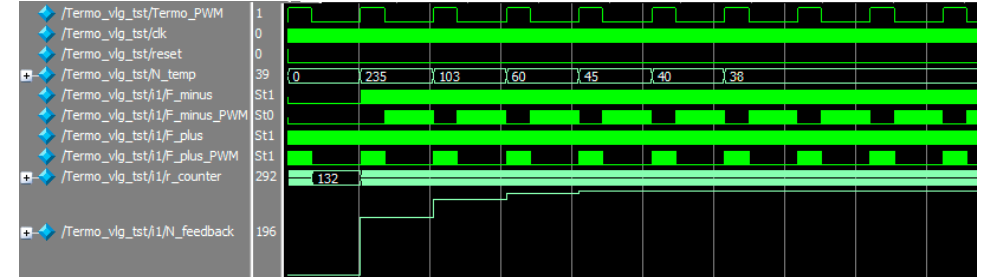
Figure 8. Result of simulation of processes in the temperature measurement system.